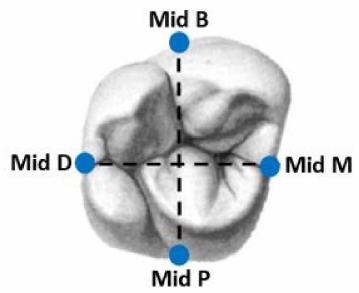
Figure 2. Four regions of interest for measurements.